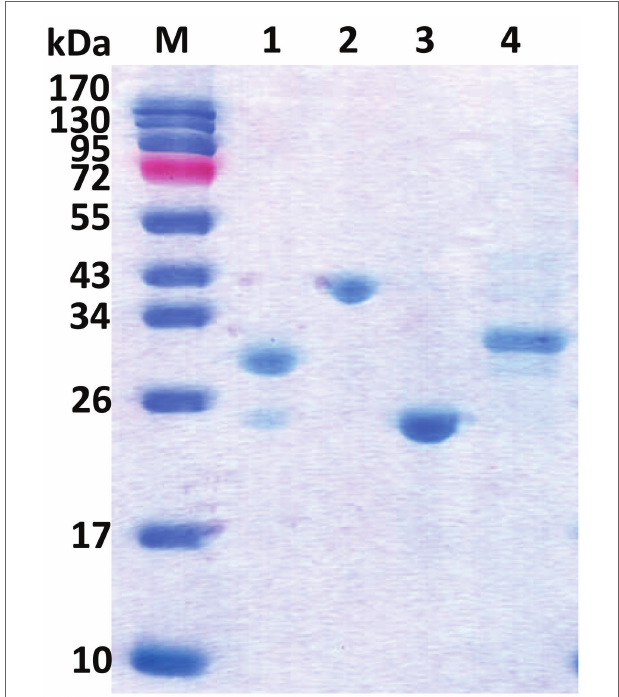
FIGURE 4 | SDS-PAGE of the recombinant Rml enzymes from S. syringae CGMCC 4.1716. Lane M, protein marker; Lane 1, Ss-RmlA (32.7 kDa); Lane 2, Ss-RmlB (37.2 kDa); Lane 3, Ss-RmlC (23.1 kDa); Lane 4, Ss-RmlD (32.4 kDa). The SDS-PAGE was performed in a 15% (w/v) gel and the proteins were visualized by Coomassie brilliant blue R-250 staining.